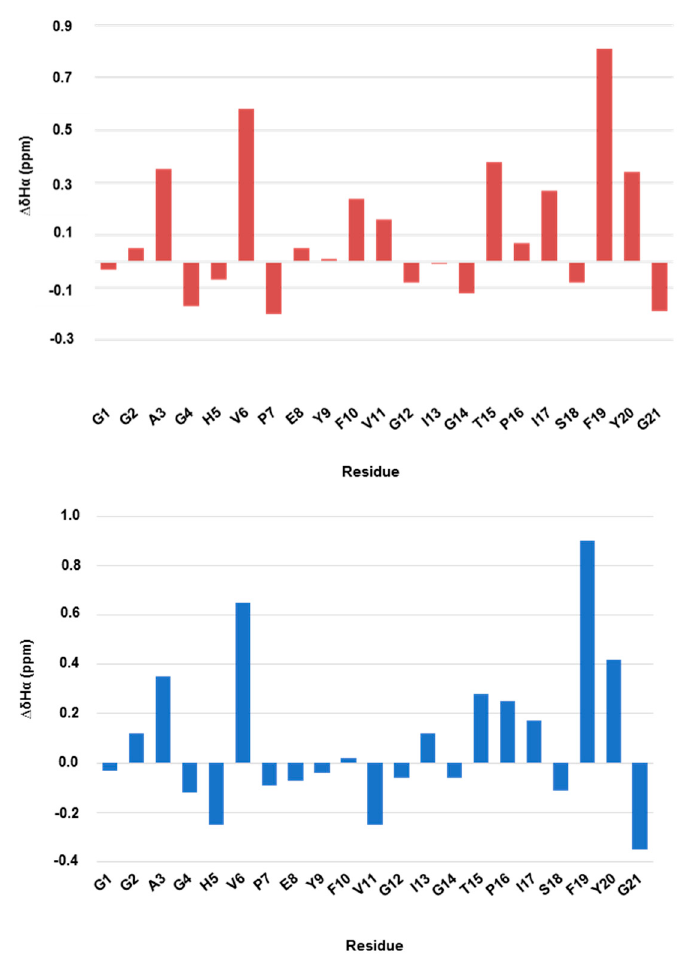
Figure 5. Histograms of chemical shift deviations from random coil for ∆ H α in the native MccJ25 (red) and new compound (blue) in methanol. Random coil values were obtained from Whishart et al. [32].